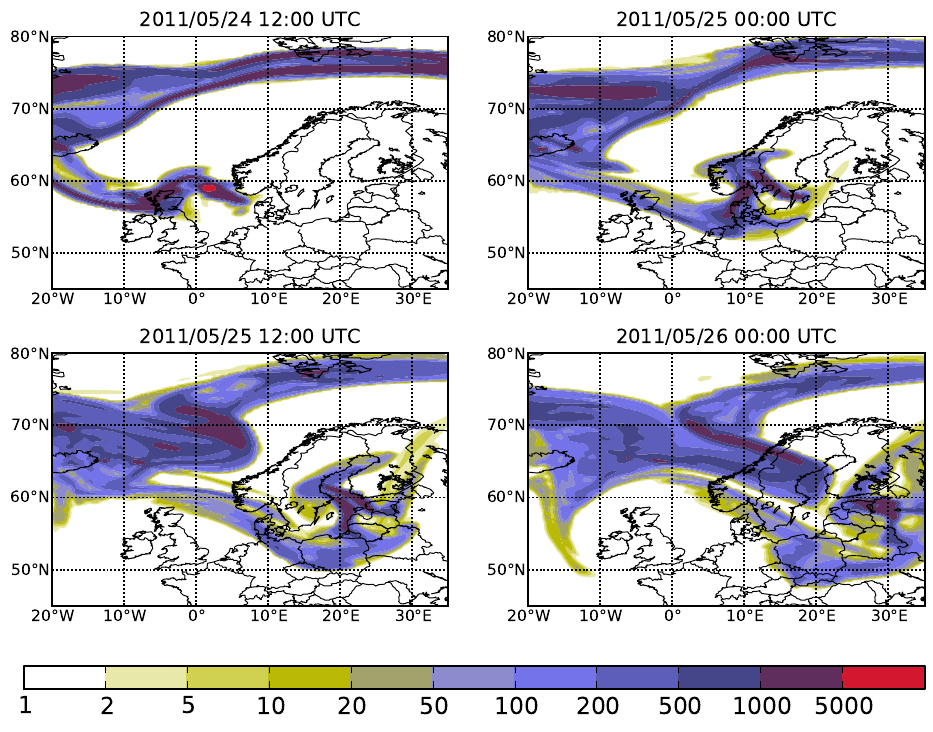
Fig. 4. The SILAM dispersion model results for the column-integrated volcanic ash concentration (mgm − 2 ) during 24–25 May 2011.